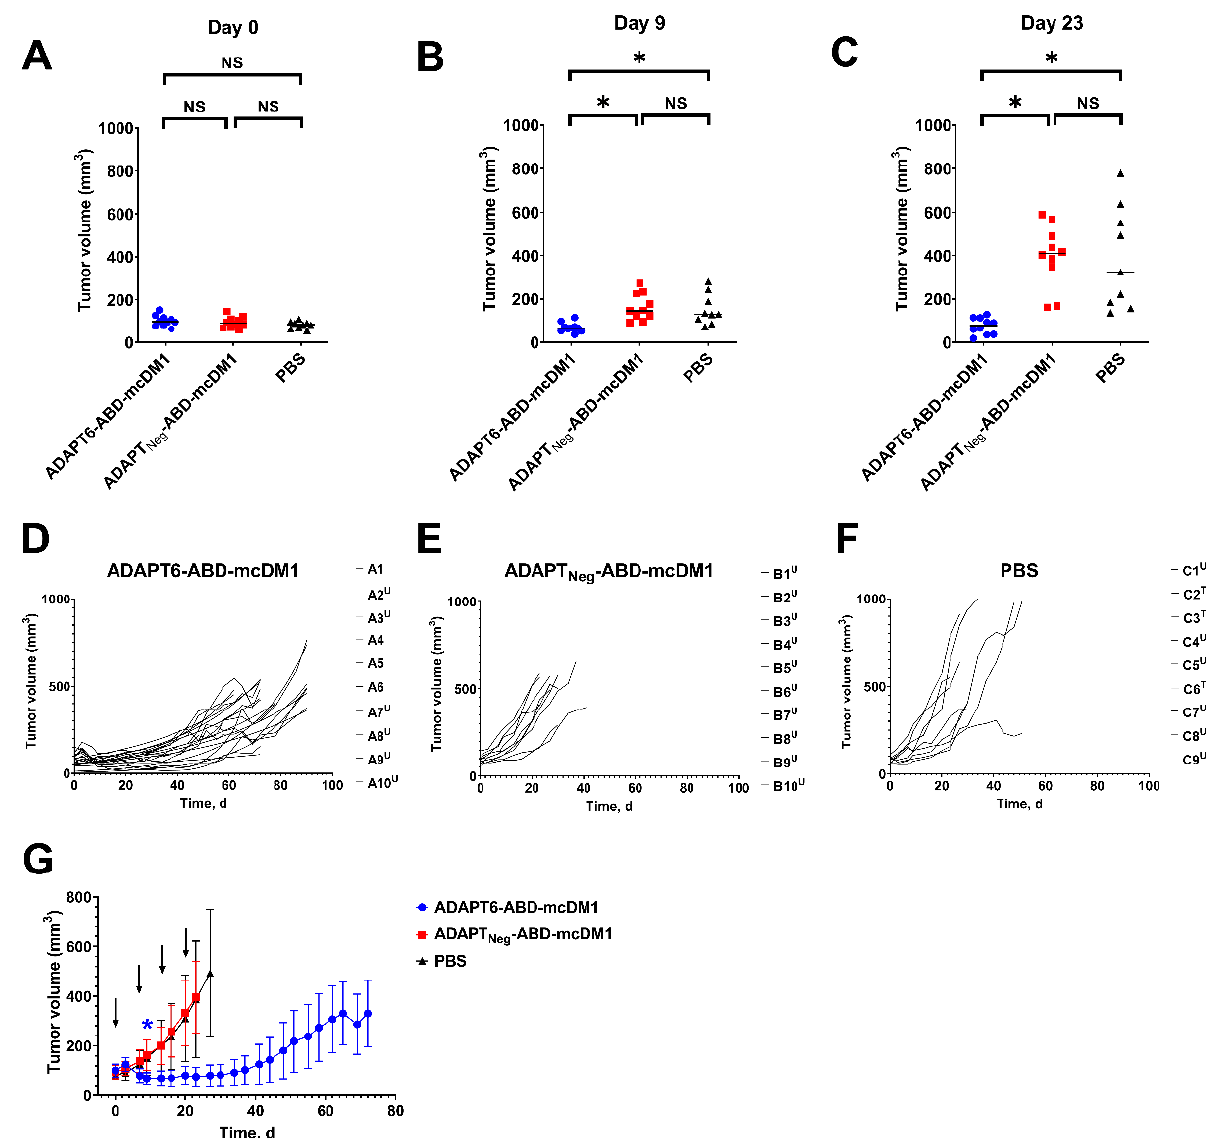
Figure 2. Comparison of tumor volumes in experimental therapy groups (n = 9–10) in BALB/c nu/nu mice bearing SKOV3 xenografts, receiving ADAPT6-ABD-mcDM1, ADAPT Neg -ABD-mcDM1 or PBS (vehicle) ( A ) at the start of the experiment (day 0), ( B ) after two treatment cycles (day 9) and ( C ) after four treatment cycles (day 23). Individual tumor volume growth curves for mice received ( D ) ADAPT6-ABD-mcDM1, ( E ) ADAPT Neg -ABD-mcDM1 or ( F ) PBS (vehicle). The mice were euthanized when the volume of the subcutaneous xenografts exceeded 1000 mm 3 (T) or ulcers on the xenografts were observed (U). ( G ) The average tumor volume (n = 9–10) in mice receiving ADAPT6-ABD-mcDM1, ADAPT Neg -ABD-mcDM1 or PBS (vehicle) once a week for four weeks. The data are presented as an average value ± standard deviation (SD). The curves were drawn until 30–33% of the mice in a group were euthanized. The arrows indicate the days when treatment was administered. NS corresponds to no statistically significant difference ( p > 0.05); * corresponds to p < 0.01 (one-way ANOVA with Bonferroni correction). The mice were euthanized at predetermined humane end-points: tumor size exceeding 1000 mm 3 , tumor ulceration, internal bleeding, and total weight loss of 15% from the treatment initiation or 10% within one week. The study was terminated 90 days after the first injection according to requirements of the ethical permit. After the mice were